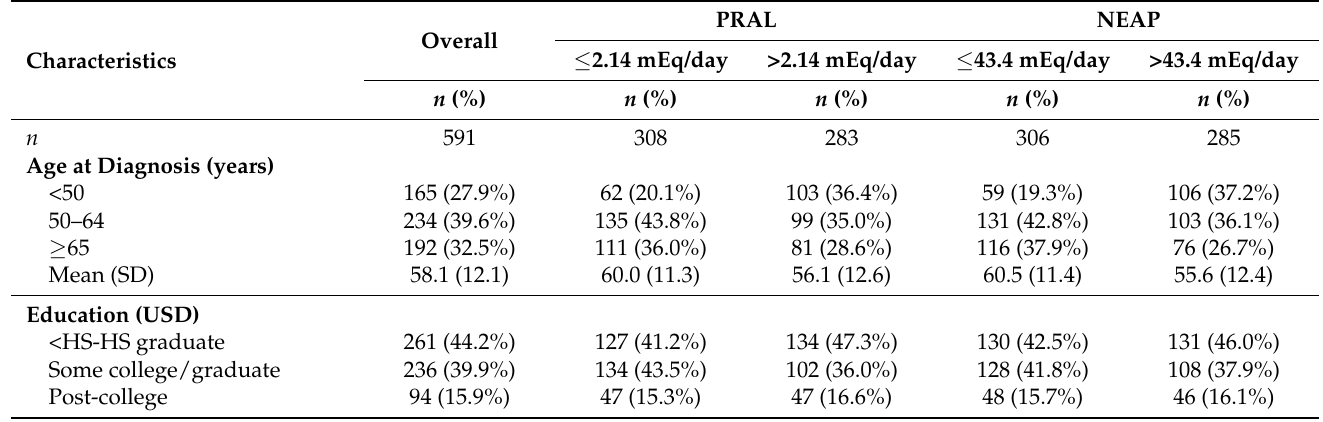
Table 1. Characteristics of the Long Island Breast Cancer Study Project women with breast cancer ( n =